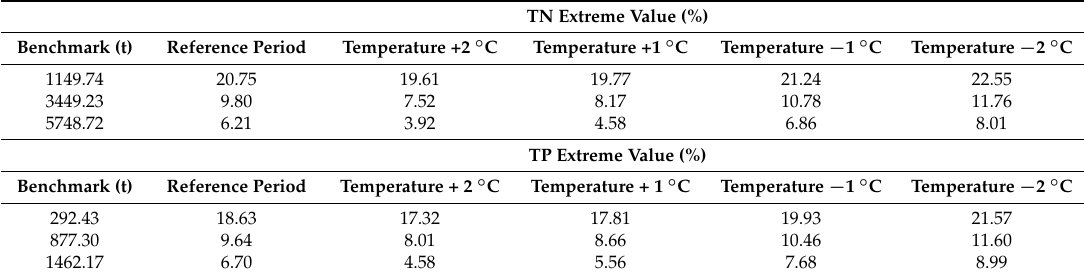
Table 5. The extreme values of TN and TP load under the Temperature Change scenario. TN Extreme Value